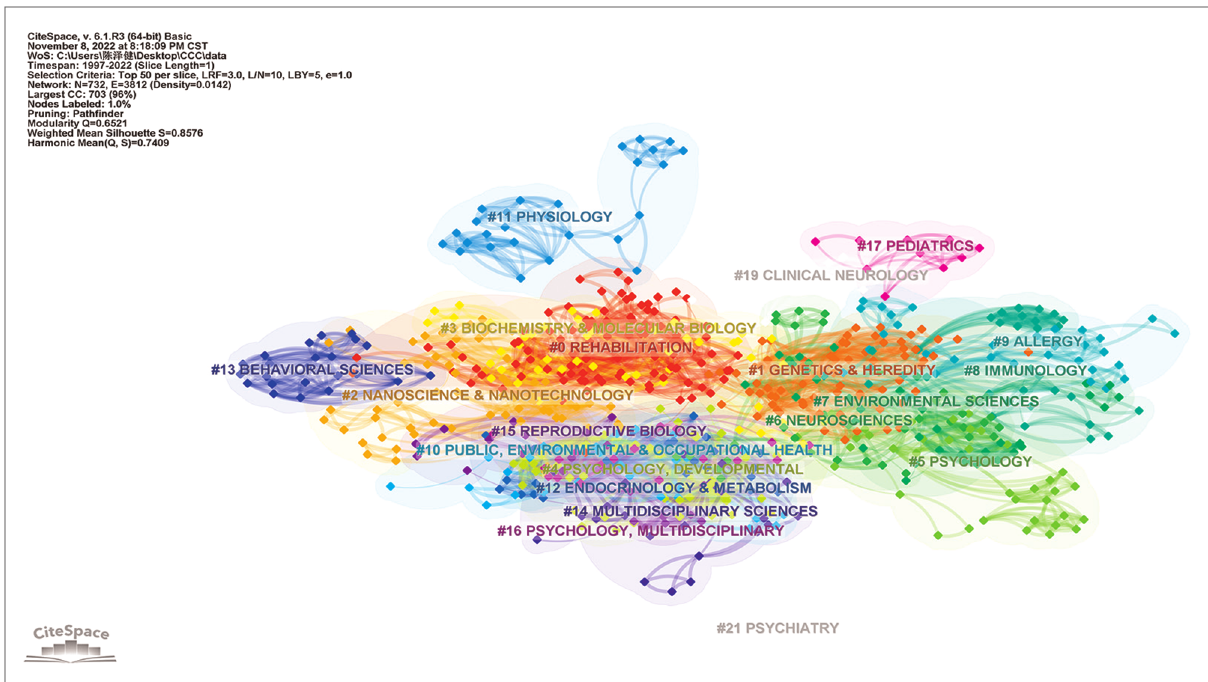
FIGURE 5 The cluster map of co-occurrence research categories related to risk factors on ASD since 1990.